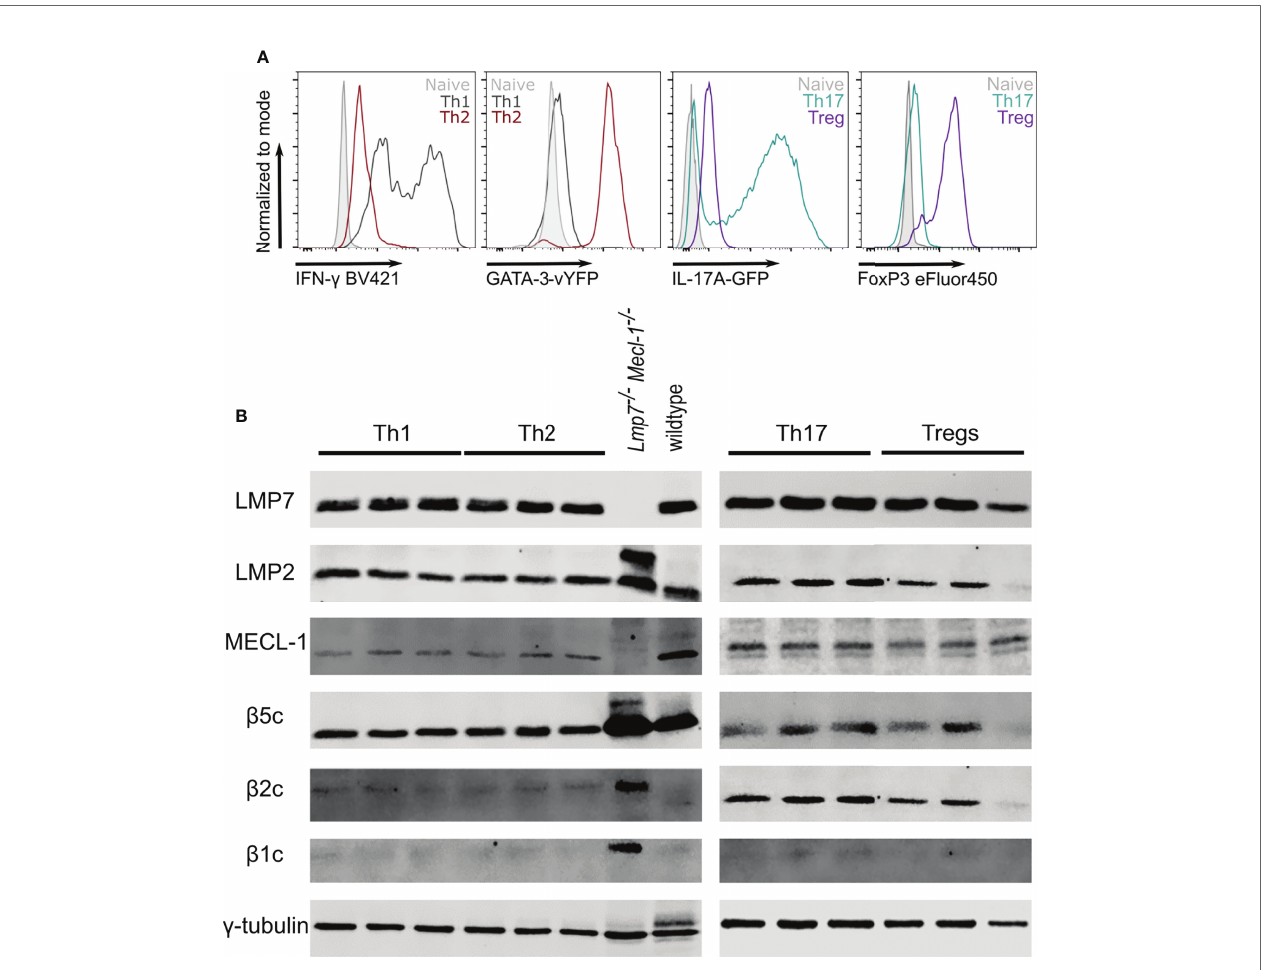
FIGURE 1 | The immunoproteasome is strongly expressed in T helper cell subsets. Naïve CD4 + T cells were magnetically sorted from spleens of GATIR and IL-17A- GFP mice and cultured with polarizing cytokine/antibody cocktails for 7 days. (A) Flow cytometric analysis of polarization on day 7. Intracellular staining for IFN- g and FoxP3 was performed for Th1 and Tregs, respectively. GATA-3 and IL-17A expression was analyzed by measuring the respective reporter fl uorochrome vYFP or GFP. Histogram overlays show fl uorescence levels in the different Th populations with naïve CD4 + T cells on day 0 as controls (grey). For each parameter, one other population is shown to demonstrate the speci fi city of the signal (Th1 – black, Th2 – red, Th17 – petrol, Treg – purple). (B) Polarized cells were harvested and lysed on day 7. Lysates were analyzed for LMP7, LMP2, MECL-1, b 5c, b 2c and b 1c by immunoblotting. g -tubulin was used as loading control. Lanes represent extracts from three different mice. Whole spleen lysates of wildtype (WT) and LMP7-MECL-1-double-de fi cient mice were used as controls. Note the additional band of LMP2 in the LMP7-MECL-1-double-de fi cient mice which likely represents the accumulated precursor that is not incorporated into the mature proteasome in the absence of LMP7 and